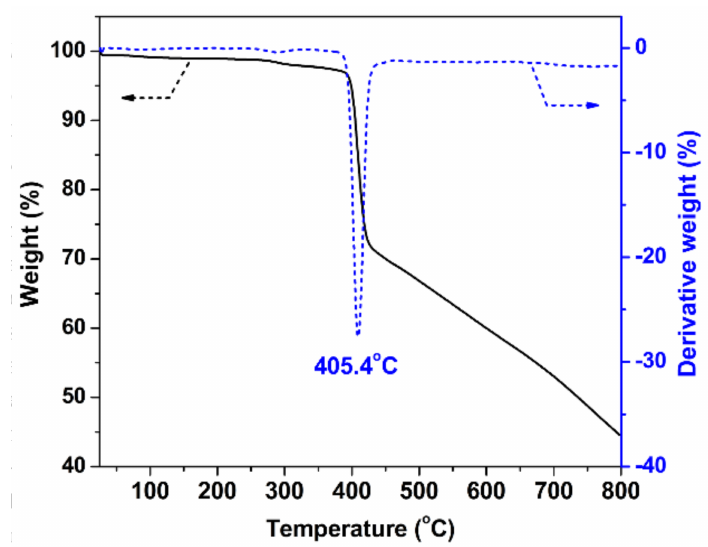
Figure 6. Thermogravimetric curve of Complex under N 2